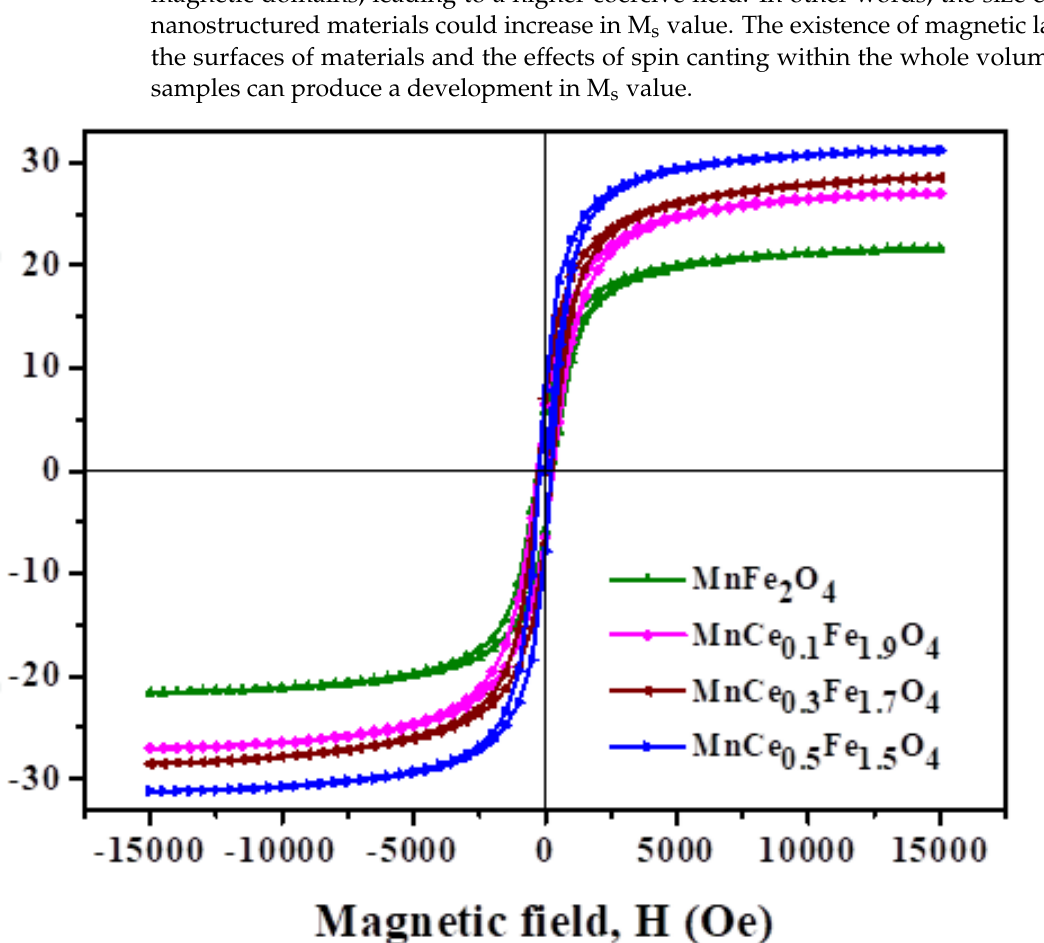
Table 2. Remnant (M r ), Coercivity (H c ), and saturation (M s ) values of spinel MnCe x Fe 2 − x O 4 (x = 0.0, 0.1, 0.3 and 0.5) NCs.